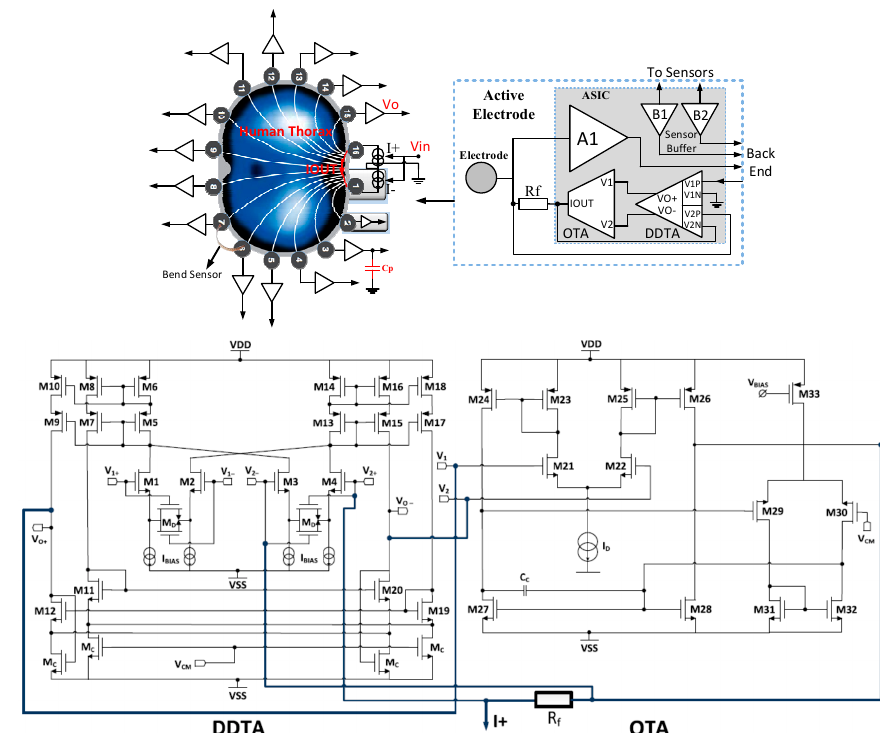
Figure 11. System level architecture and circuit level design of the current driver of an active electrode